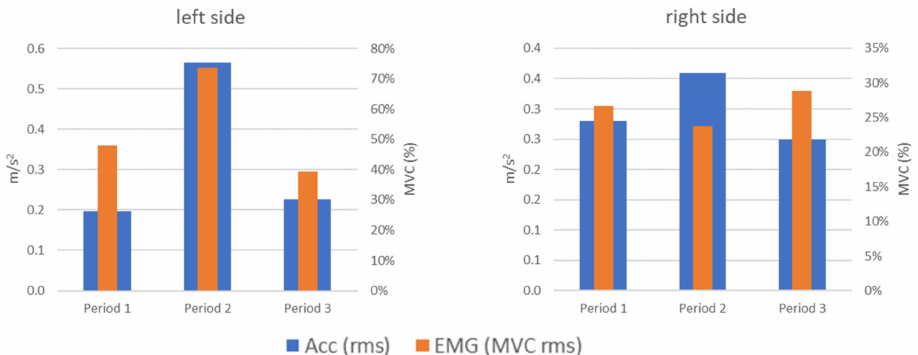
Figure 12. Comparison of acceleration and EMG signals for OP (opening with